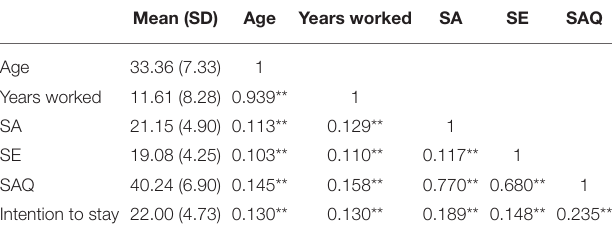
TABLE 2 | Correlation analysis of SA, SE, SAQ, and Intention to Stay ( r a